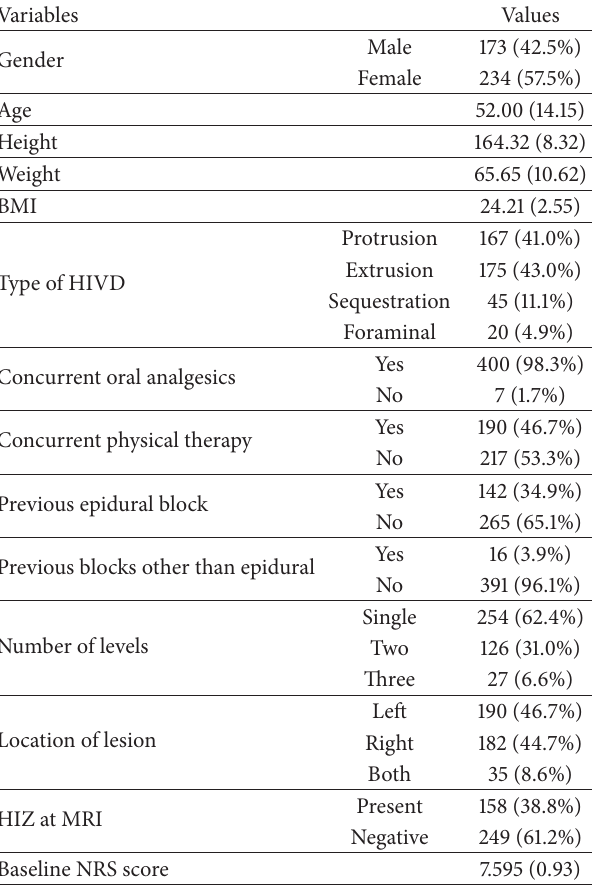
Table 1: Demographic and clinical characteristics of the study patients ( 𝑛 = 407